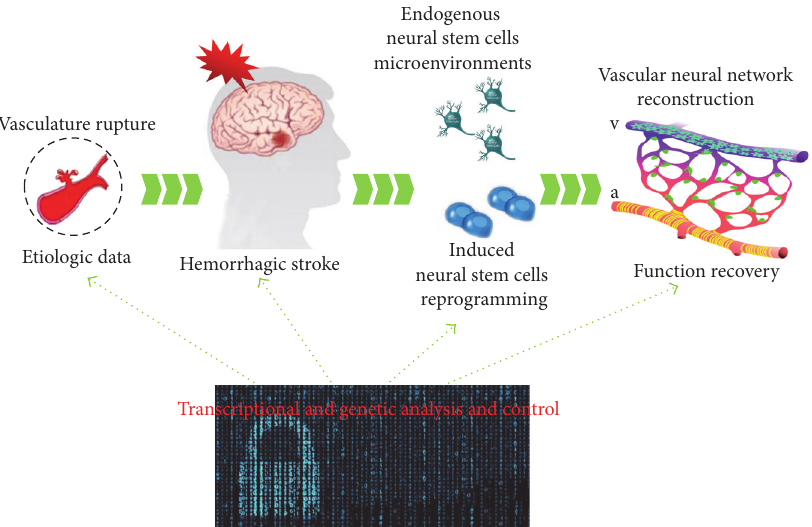
Figure 1: Diagram of transcriptional and genetic analysis and control for the function recovery in hemorrhagic